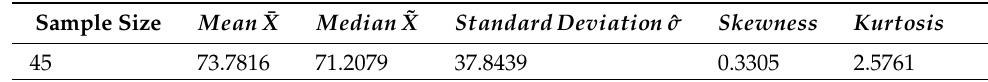
Table 21. Theoretical statistical measures of SBXLL from